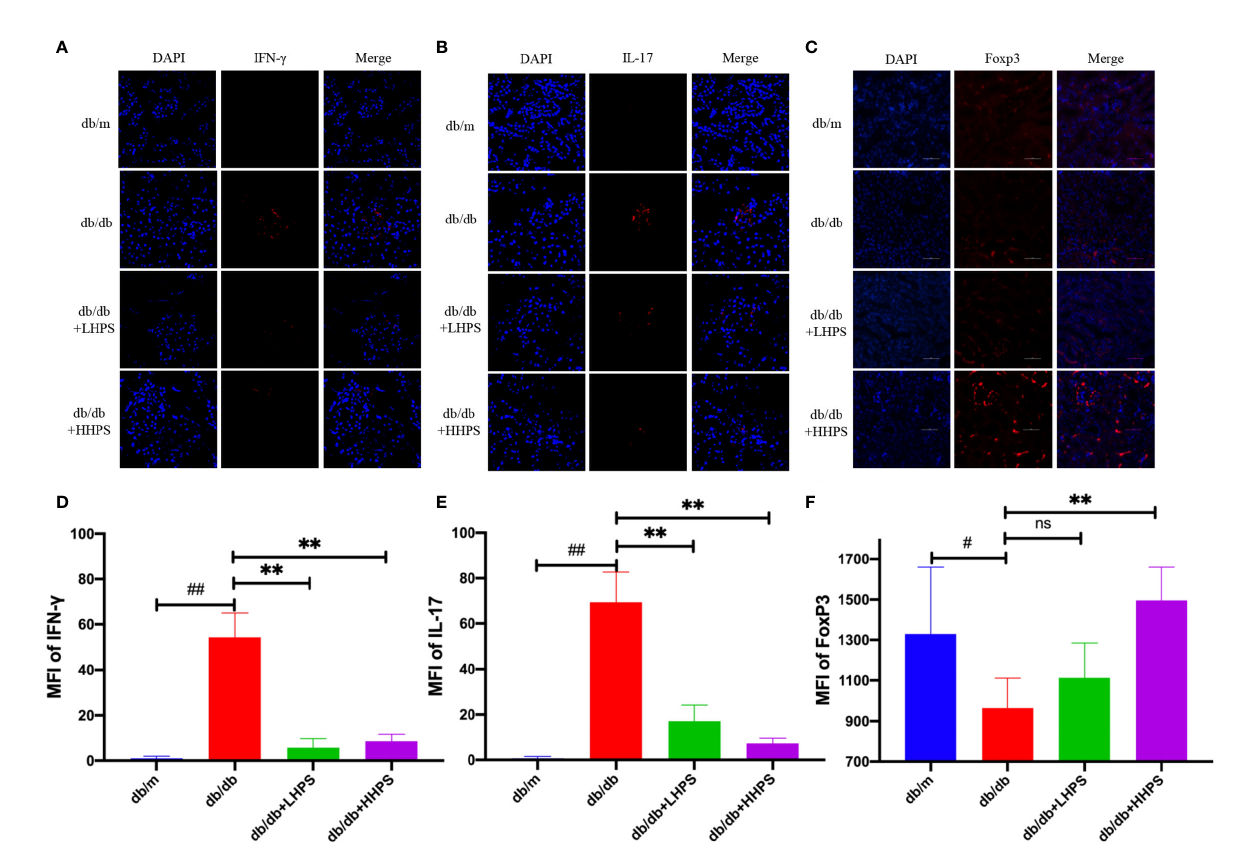
FIGURE 7 | The effects of Hyperoside on the imbalance of T cell differentiation in the kidney. Immuno fl uorescence staining shows the expressions of CD4+ T-cell associated cytokines, IFN- g [red, (A) ], IL-17 [red, (B) ], and Foxp3 [red, (C) ] in kidney tissue of db/db mice treated with HPS. Quantitative analyses of IFN- g (D) , IL-17 (E) , and Foxp3 (F) expressions in kidney tissue were also performed (Original magni fi cation: ×400, scale bar = 50 m m). Values are presented as the means ± SD. Differences between experimental groups were evaluated using ANOVA. (n = 5 per group, # P < 0.05 and ## P < 0.01 vs db/m ; ** P < 0.01 vs db/db ; ns, not signi fi